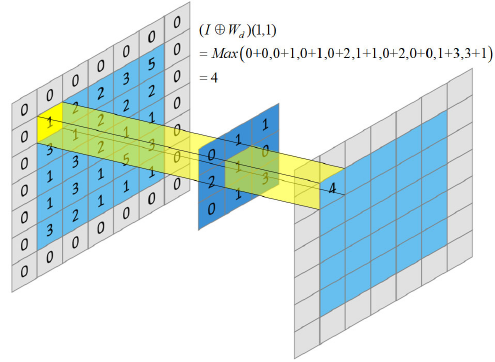
Figure 3. Example diagram of a dilation operation.